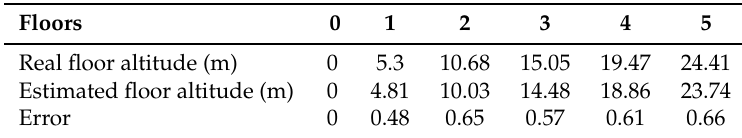
Table 7. Ground truth, estimated altitude and error for Technical University of Munich (TUM) Main Campus.